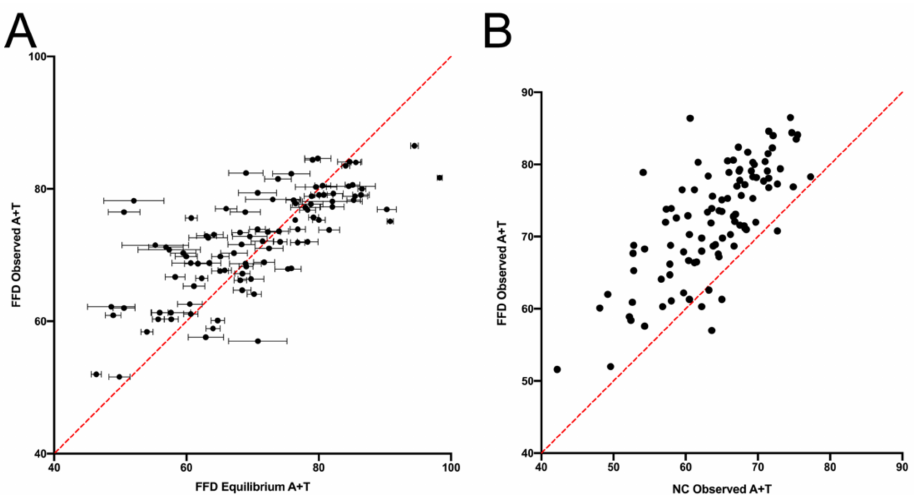
Figure 4. A comparison of ( A ) the predicted and observed A+T content at FFD sites and ( B ) the observed A+T content at NC and FFD sites. For the predicted A+T content of FFD sites, error bars were determined using the resampling methodology described in the Materials and Methods Section.